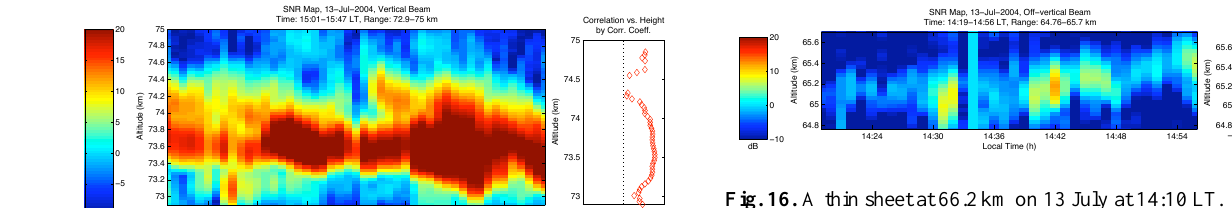
Fig. 16. A thin sheet at 66.2 km on July 13 at 14:10 LT.